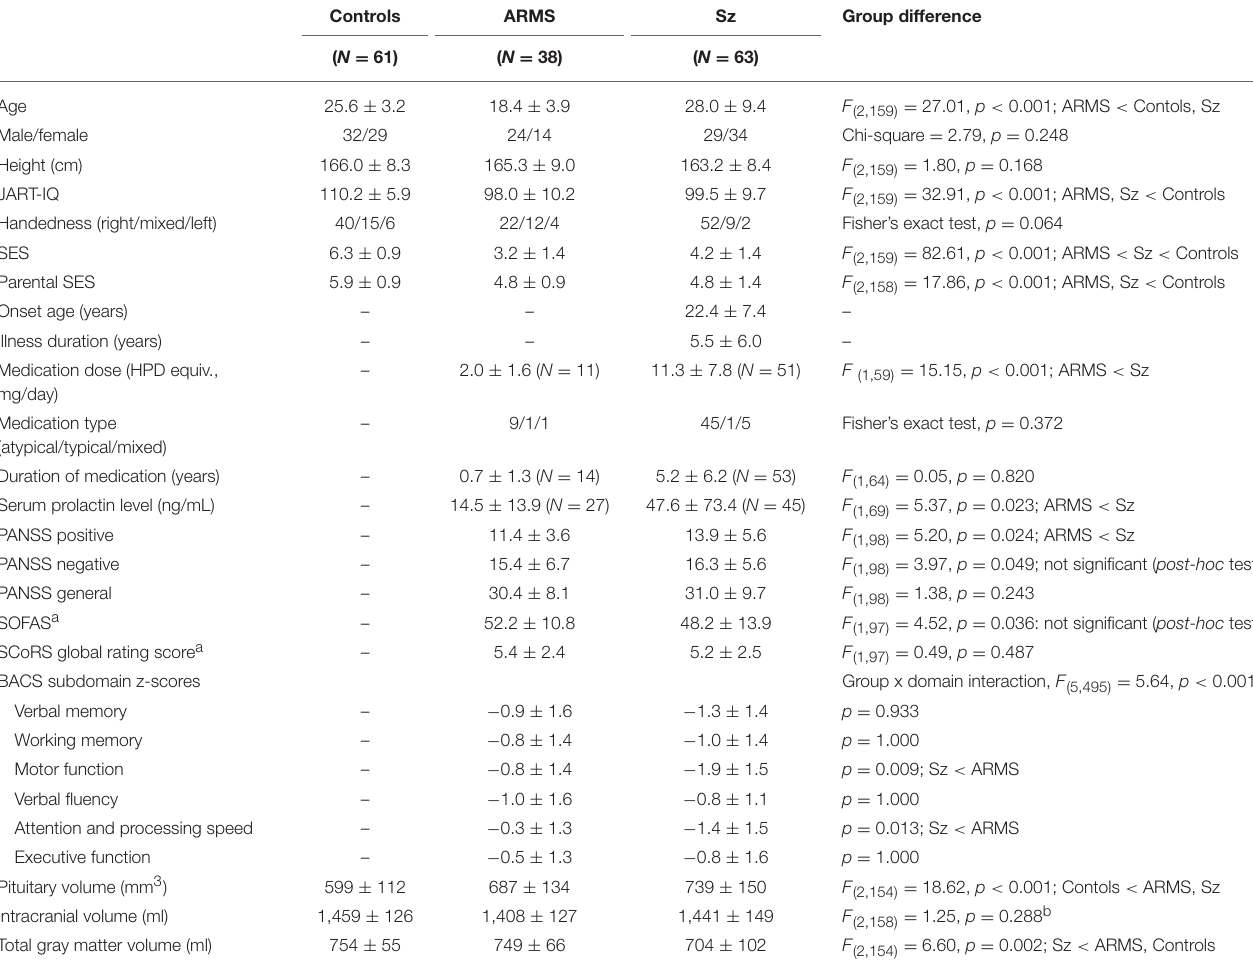
TABLE 1 | Demographic/clinical data, socio-cognitive functions, and brain measures in the ARMS, schizophrenia, and control subjects.